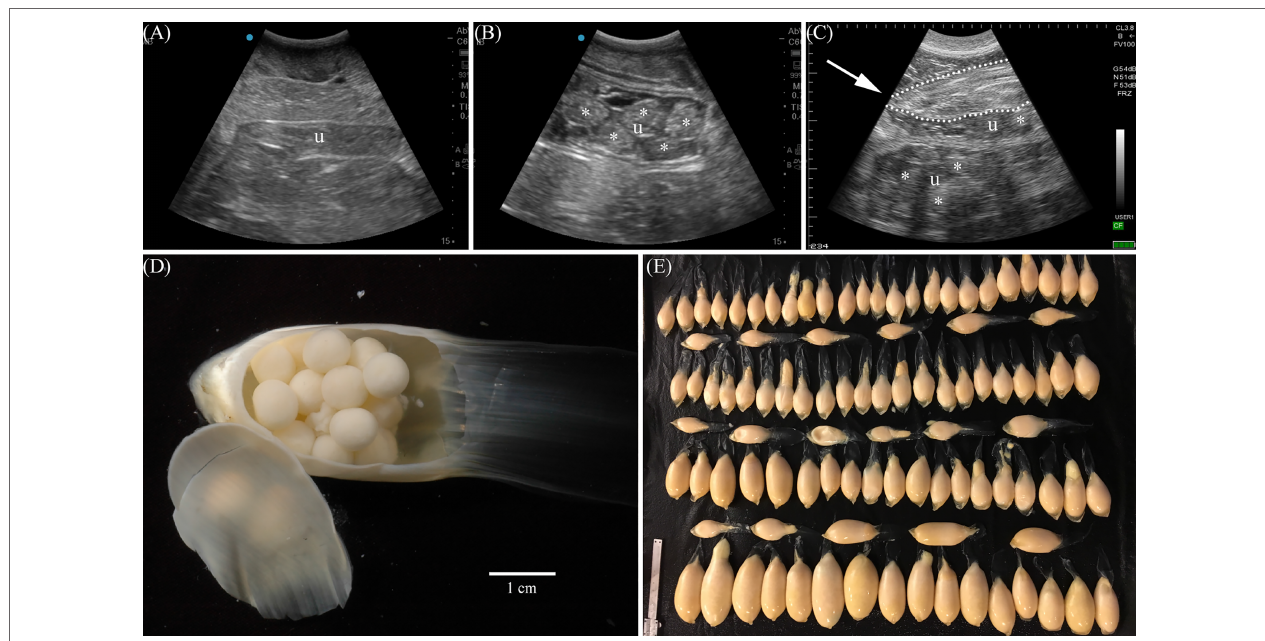
FIGURE 1 | Ultrasonography was used to determine contents of the paired uteri. Sonographs (longitudinal) show a uterus (u) with no contents typical of resting females (A) , a uterus with egg cases (*) (B) , or both uteri, one with egg cases and the other with a developing embryo (dotted outline, arrow indicates snout) and egg cases (*) in early gestation (C) . Each egg case (D) contains multiple eggs enclosed by a soft and pliable case secreted by the oviducal gland. Aquarium females without developing embryos were observed to release hundreds of uterine egg cases (E) up to 2 years after ovulation.